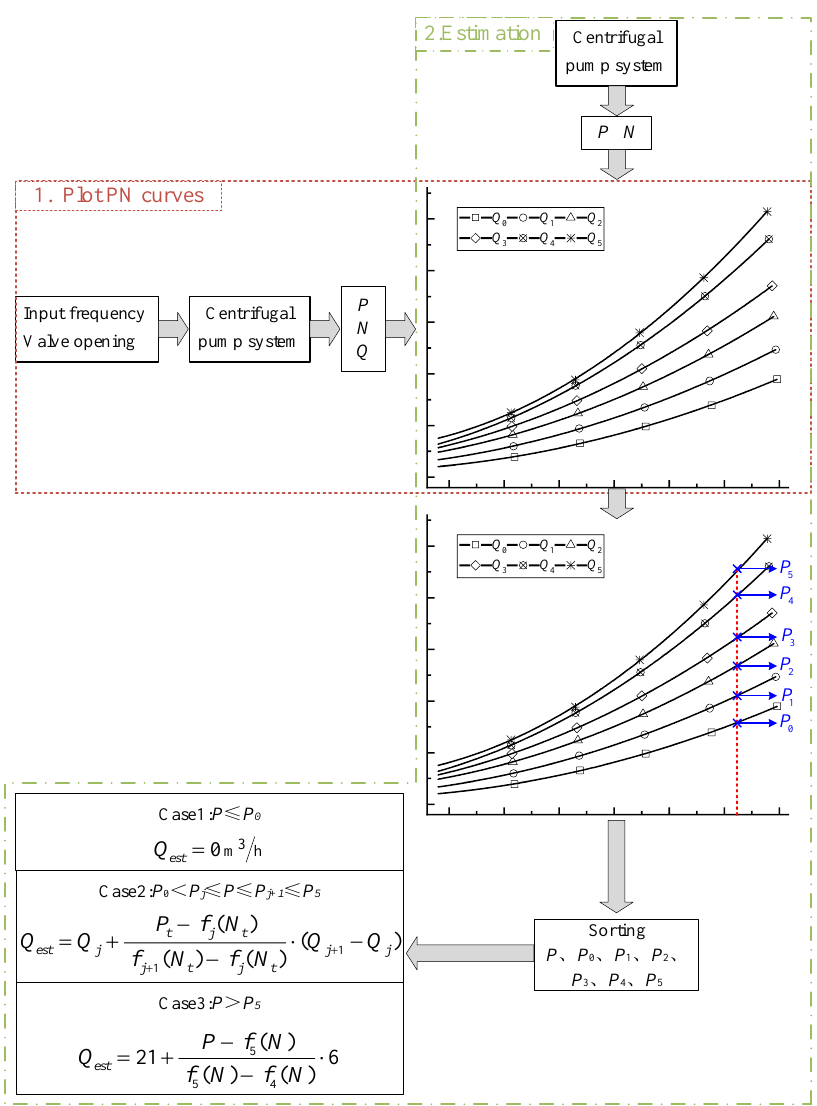
Figure 9. Flow chart of flow rate estimation algorithm.